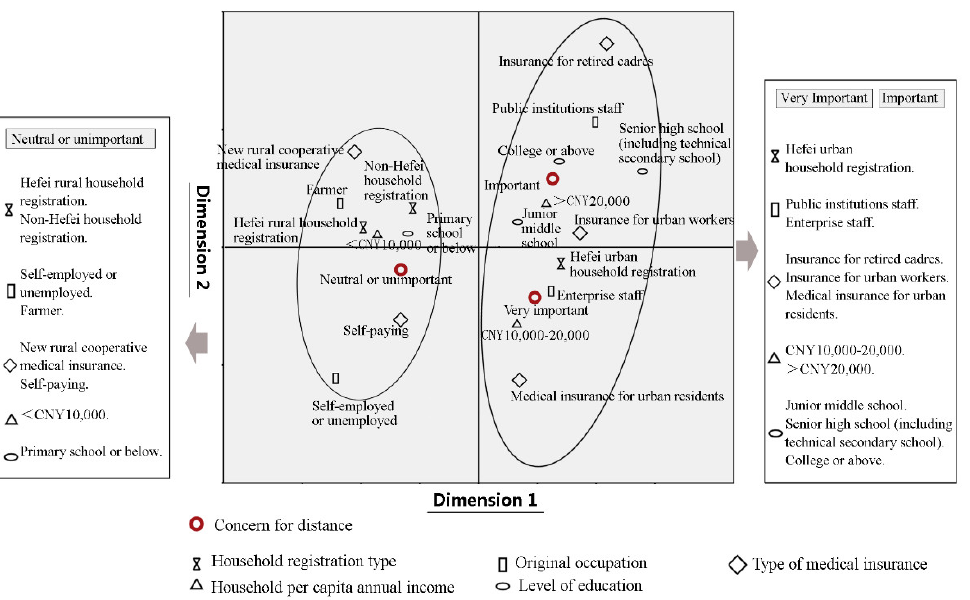
Figure 4. Correspondence analysis of the attributes of the elderly and their preference for